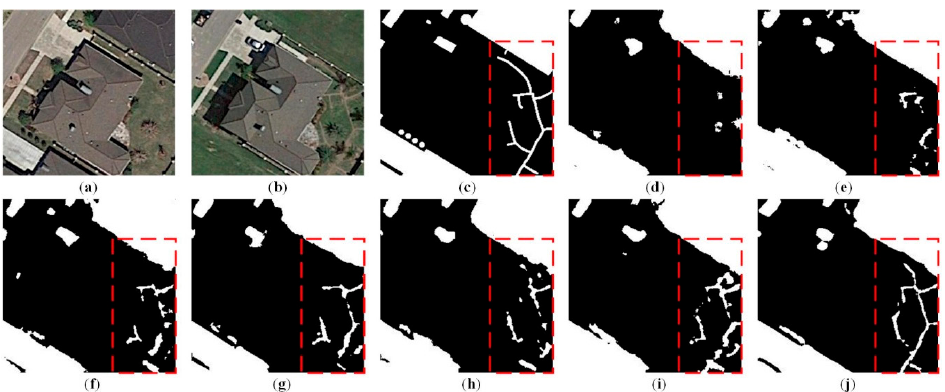
Figure 11. Visual comparisons of change detection results using different approaches for area 5: ( a ) image 𝑇 (cid:2869) , ( b ) image 𝑇 (cid:2870) , ( c ) reference change map, ( d ) CDNet, ( e ) FC-EF, ( f ) FC-Siam-conc, ( g ) FC-Siam-diff, ( h ) FC-EF-Res, ( i ) FCN-PP, and ( j ) proposed method. The changed parts are marked in white while the unchanged part are in black.